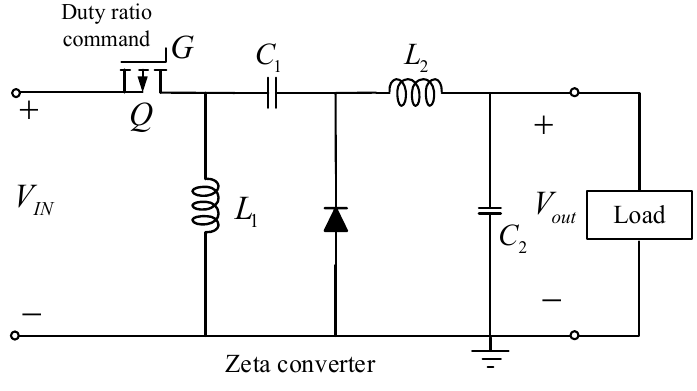
Figure 1. Zeta type buck-boost power converter.